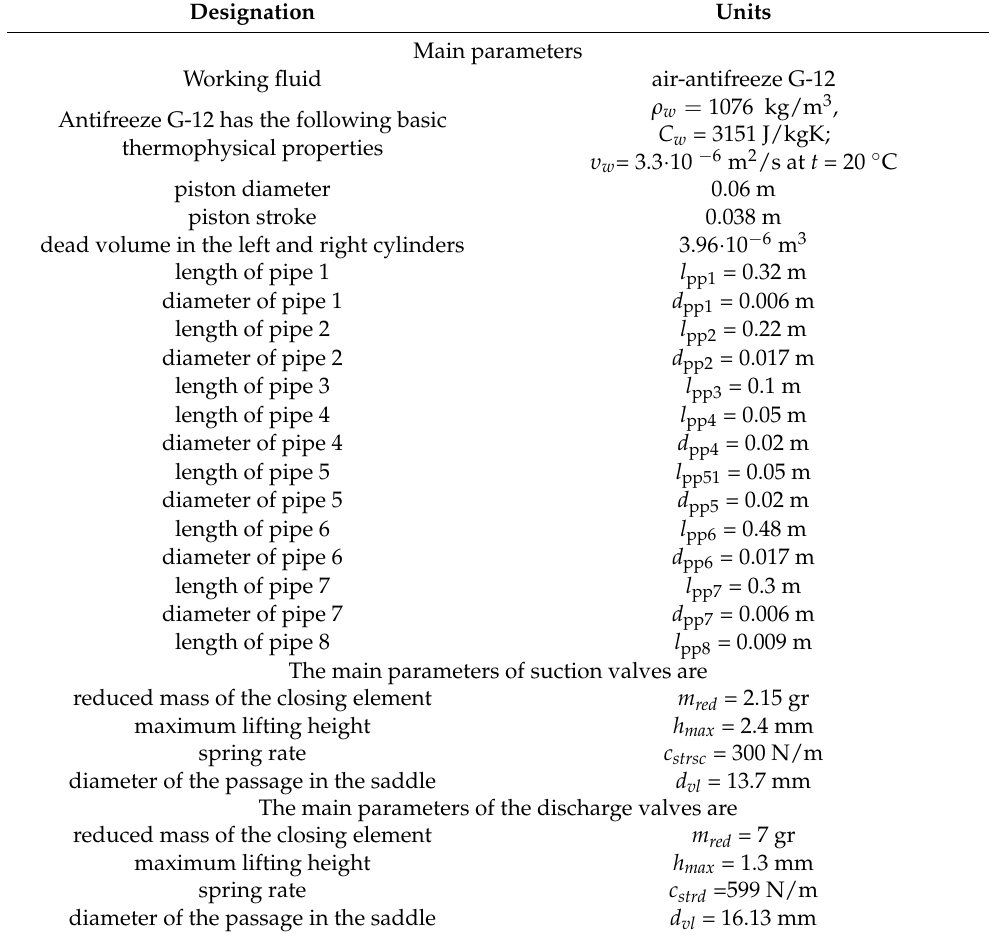
Table 1. Main parameters of the experimental